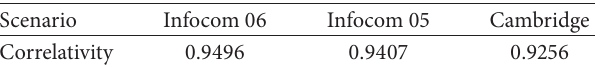
Table 5: Mantel Test results on the real and IHC-generated social interaction